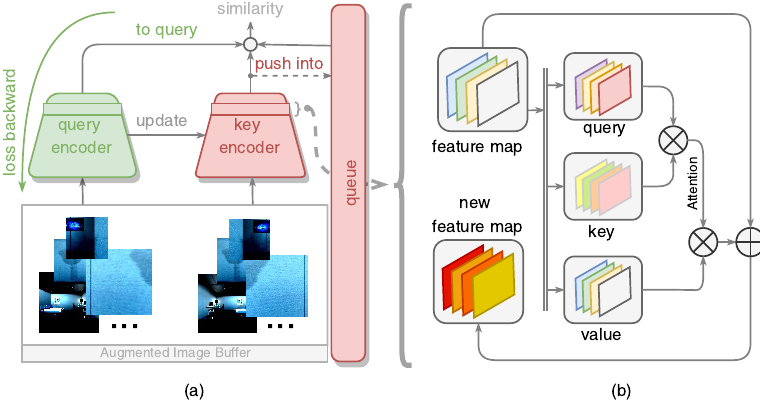
Figure 1. ( a ) Contrastive learning model. The query encoder and key encoder respectively take augmented images from the buffer as the input and maximize their similarity as much as possible. ( b ) Attention mechanism (self-attention) implementation. The ⊗ represents matrix multiplication operation and the ⊕ is matrix addition operation.